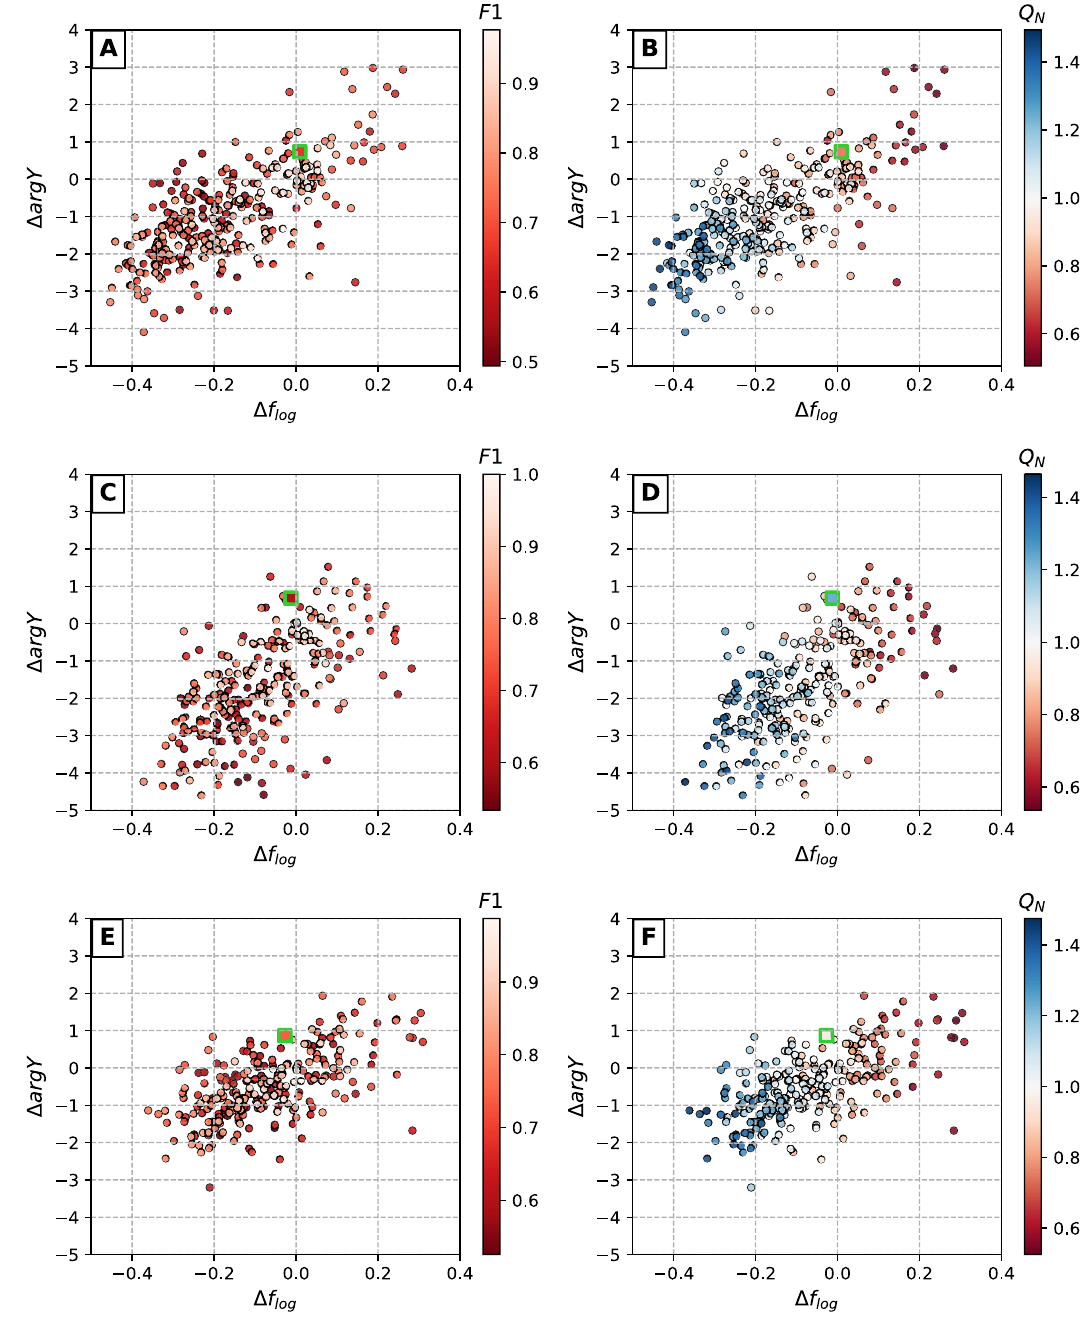
Figure 7. Dependencies between defect detection accuracy (expressed in terms of F 1 and Q N ) and deviations in corresponding EIS spectra. Coloured dots represent synthetically generated defect sets at varying detection accuracy levels (Table 2), squares with green borders indicate real detection results obtained with CNN model (Table 3). Scatter plot pairs A/B, C/D and E/F represent AFM surfaces 1, 2 and 3